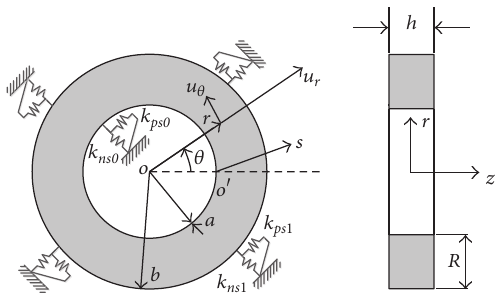
Figure 1: Sketch of an elastically restrained annular